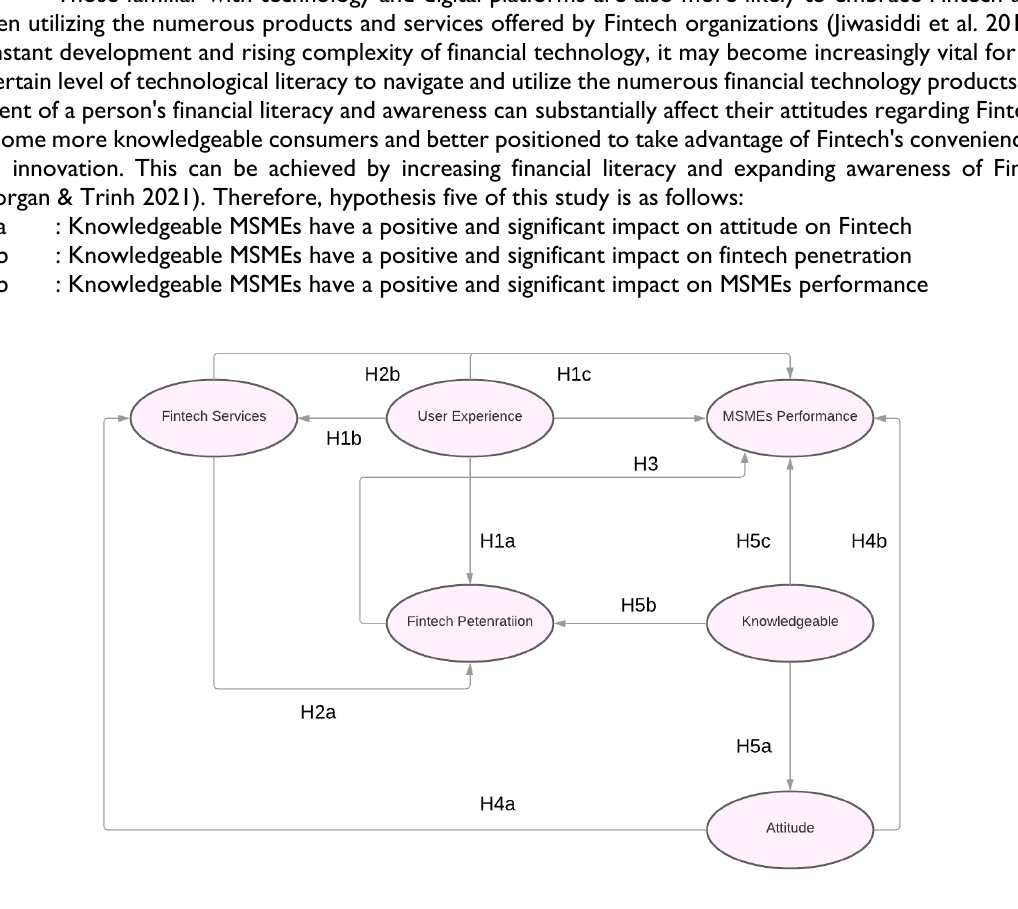
Figure 1. Conceptual hypothesis